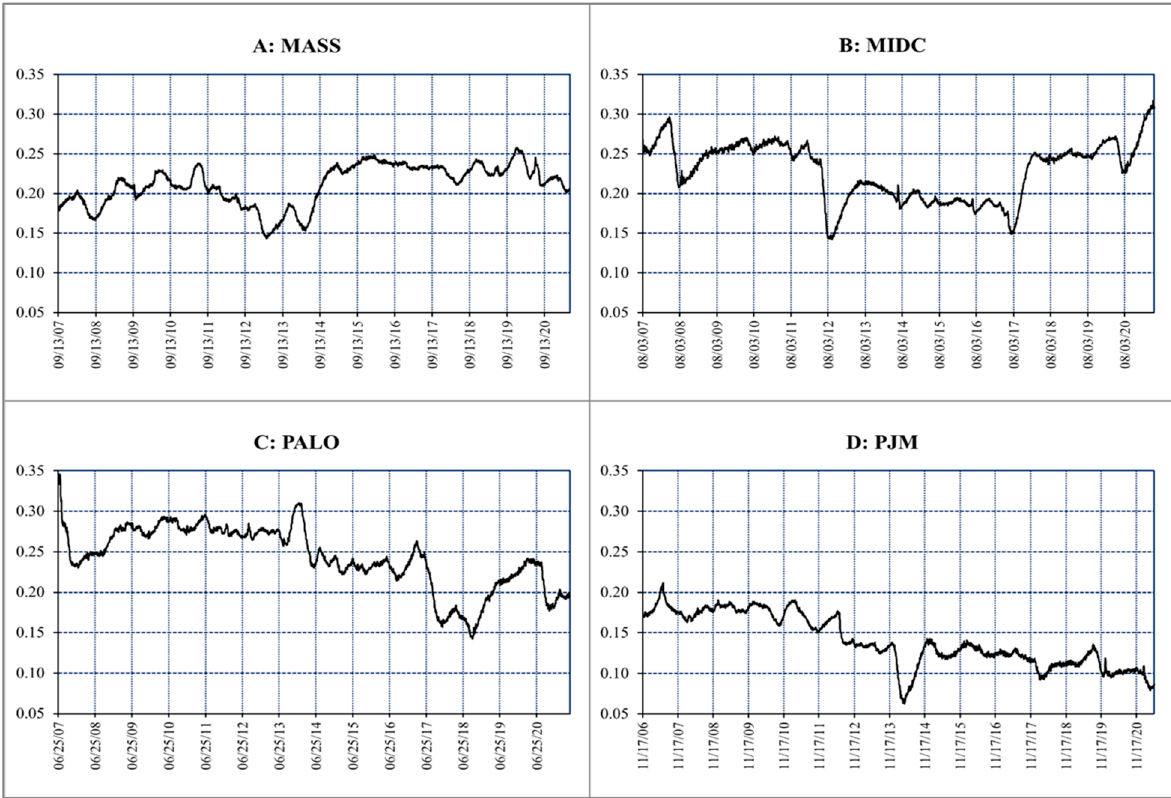
Figure 3. Dynamic Hurst exponents evolution for electricity indices ( q = 2, and window = 1500).